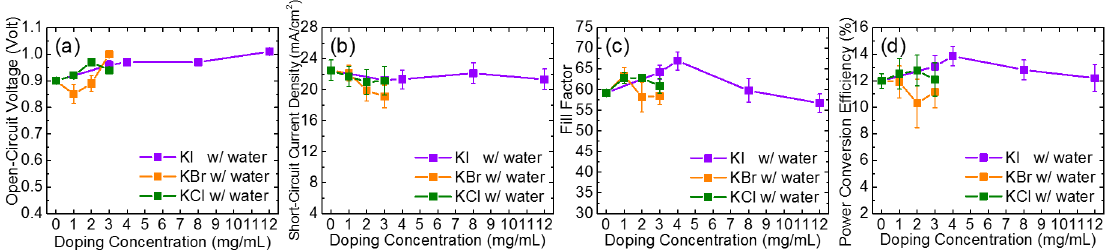
Figure 2. The changes in ( a ) V OC ; ( b ) J SC ; ( c ) FF (fill factor); ( d ) power conversion efficiency (PCE) of